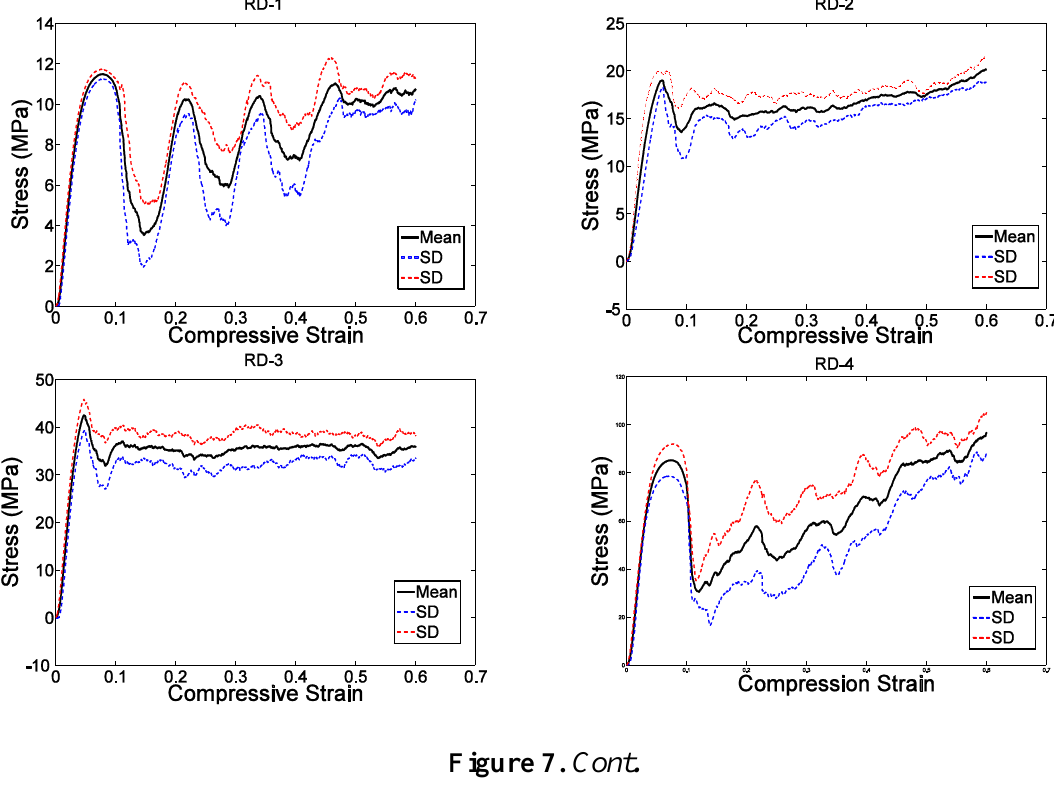
Figure 6. Compressive stress- versus -compressive strain curves for specimens based on the truncated cuboctahedron unit cell and with different porosities (see Table